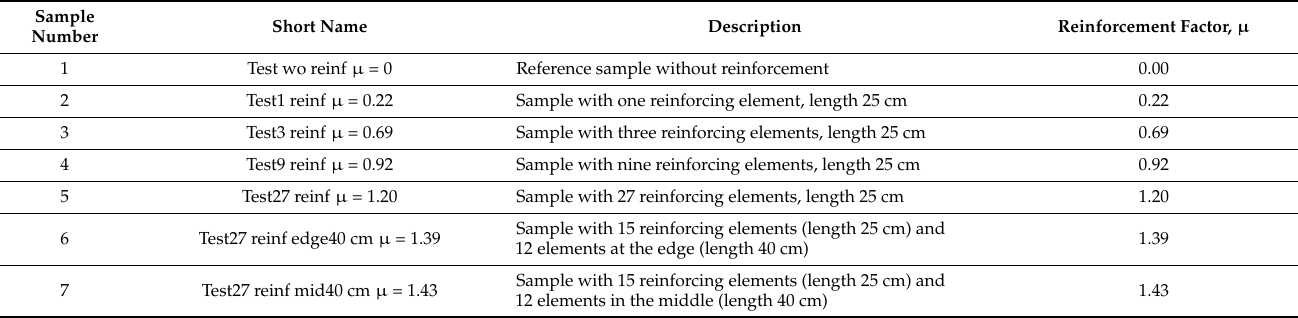
Table 1. Summary of the investigated samples.